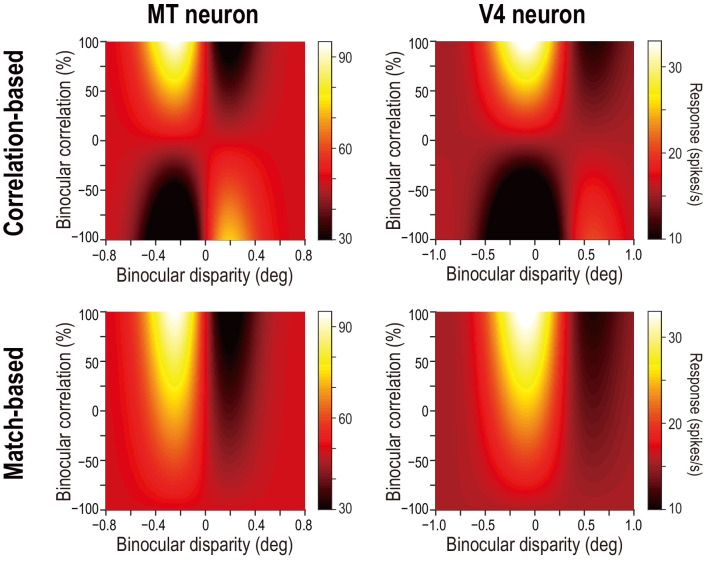
Predicted response maps for example MT and V4 neurons.Compare the observed response maps for the same neurons (shown in Figure 2C,D) and the predicted maps shown here. The observed map for the example MT neuron is closer to the correlation-based prediction (top left), whereas the observed map for the V4 neuron is closer to the match-based prediction (bottom right). We constructed the predictions for each example neuron as follows: we started with the Gabor functions fitted to the disparity-tuning data for correlated RDSs (i.e., at 100% binocular correlation). Next, we computed the predicted responses at lower correlation levels using the linear functions shown in Figure 4A; these functions dictate how the tuning amplitude and shape should change with decreasing binocular correlation for pure correlation-based and match-based models. Specifically, we multiplied the signed amplitude ratio of the correlation-based representation or of the match-based representation by the Gabor amplitude at 100% correlation. The predictions were plotted using the same color ranges as the corresponding observed data.